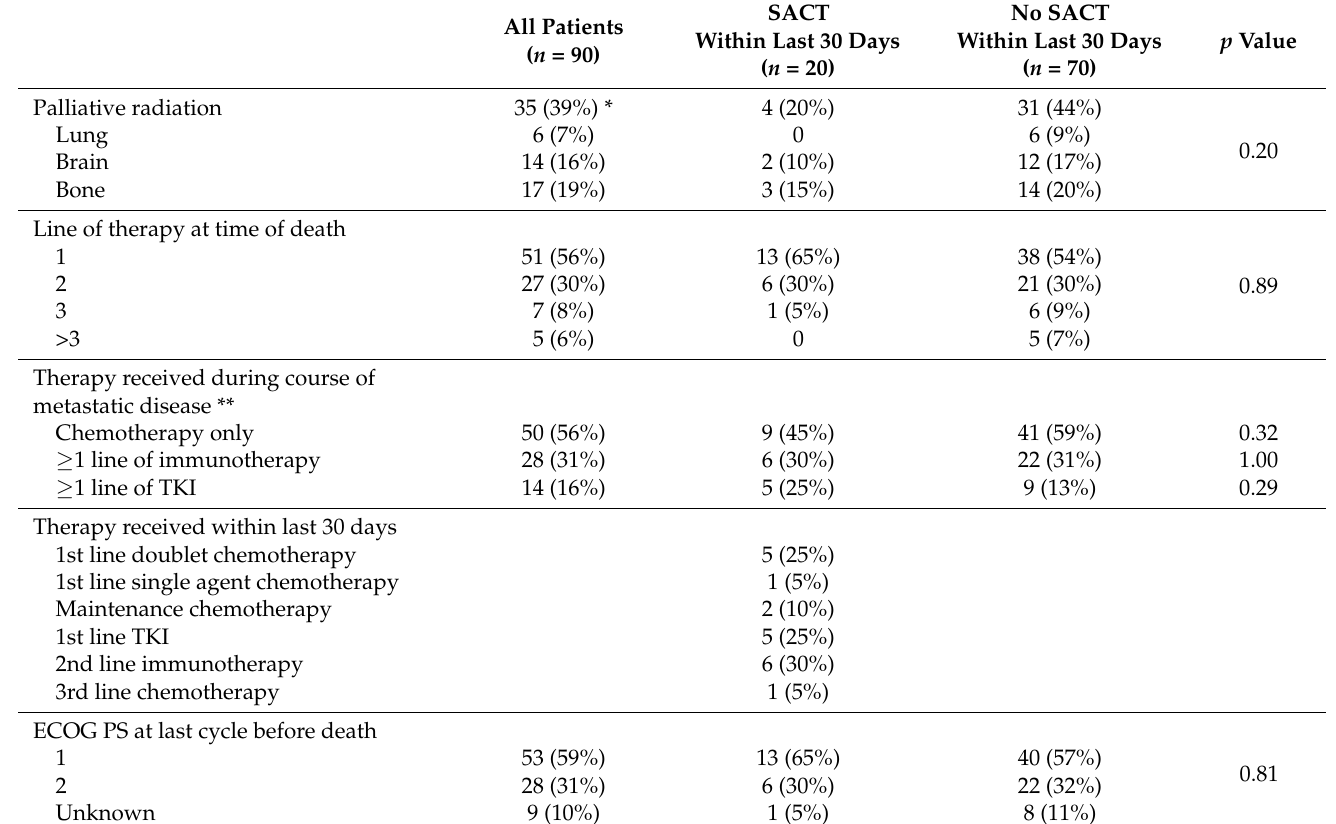
Table 3. Treatments and outcomes according to timing of last systemic